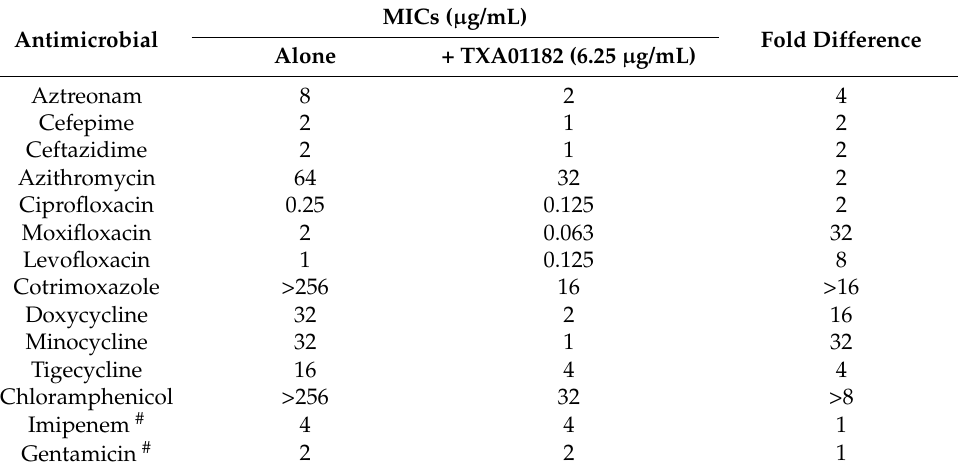
Table 3. Potentiation of different classes of antimicrobials by TXA01182 against P. aeruginosa ATCC